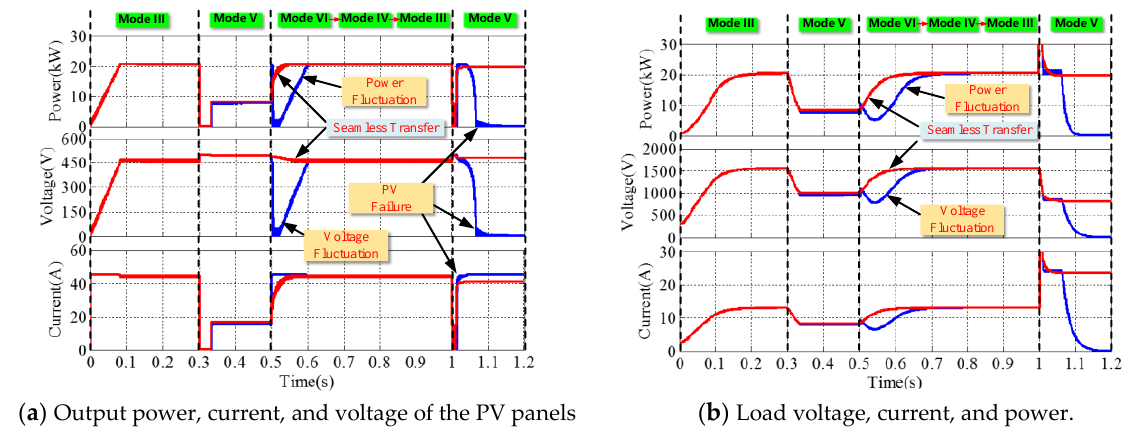
Figure 10. Results of seamless transfer and anti-dead zone control simulation.